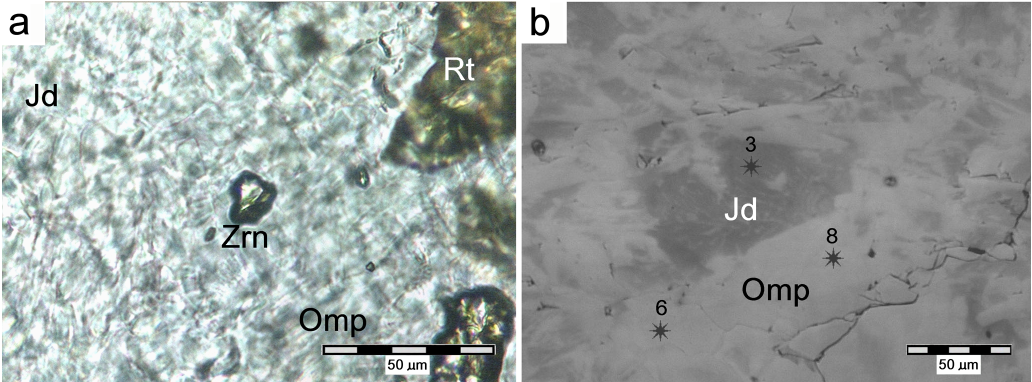
Figure 9. Photomicrographs of mixed Na pyroxenite: (a) small zircon (Zrn) and rutile (Rt) in a matrix of pyroxenes (Jd; Omp), whose zoning is appreciated only at high magnification (6636, PPL). (b) The complex zoning of pyroxenes is evident: small and “relict” jadeite crystals (Jd) are surrounded by a younger omphacite matrix (Omp), commonly slipping inside and partly corroding them (6636, SEM image, BSE; the numbered stars indicate the spots in which EDS analyses were collected; see Table S5).